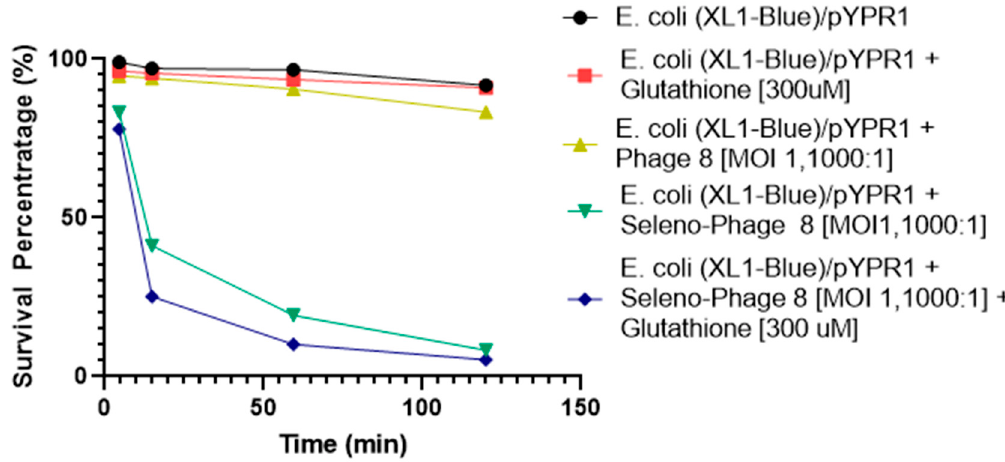
Figure 3. The effect of selenium-attached phage #8 on the viability of E. coli XL1-blue/pYPR1 under added oxygen. Survival of the Y. pestis F1-antigen-expressing E. coli XL1-blue/pYPR1 strain in the presence of selenium-labeled phage #8, an MOI (multiplicity of infection) of 1000:1, and 21% oxygen, with and without reduced glutathione (300 µ M) in PBS. The control contained bacteria pYPR1 in PBS. Other controls included pYPR1 with either reduced glutathione or phage #8 in PBS. The experiments were carried out at room temperature for two hours. After several time points, aliquots of the solutions were serially diluted and plated on LB agar supplemented with 100 µ g/mL carbenicillin and c.f.u. was counted after overnight incubation. Multiplicity of infection (MOI) is the ratio of phage to